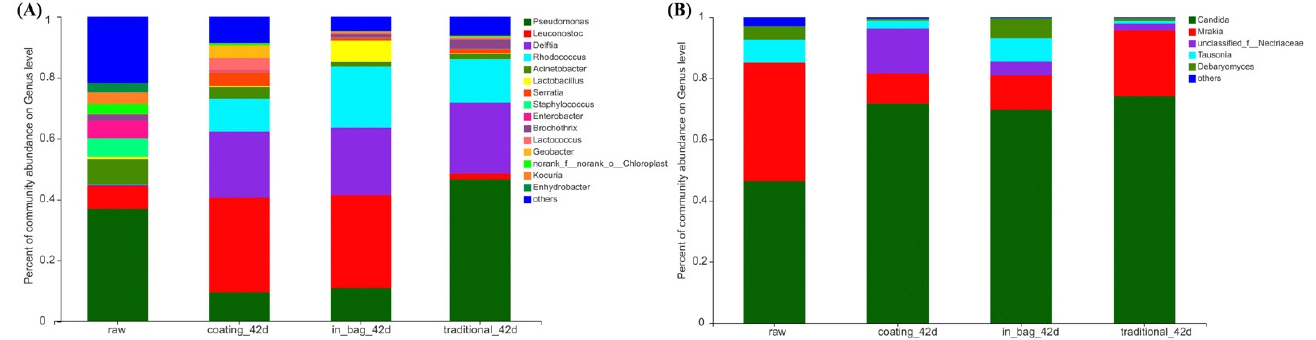
Figure 3. Effects of different treatments on bacterial community ( A ) and fungal community ( B ) of dry-aged beef at genus level.